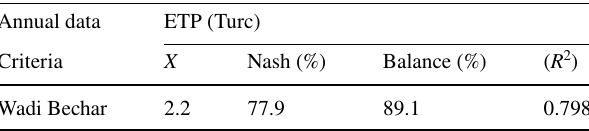
X = ETP correction coefficient (mm)